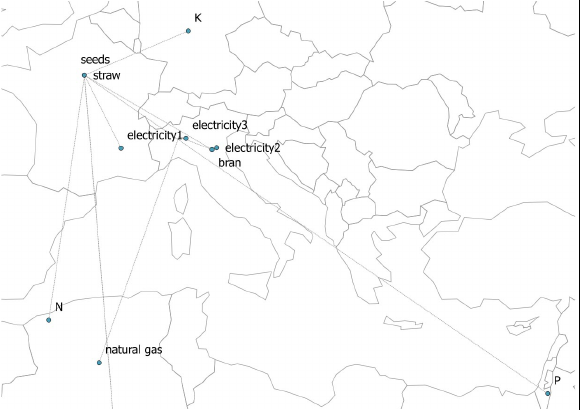
Figure 3. Nodes (points) mapped in an IG of a bread supply chain, average italian practice